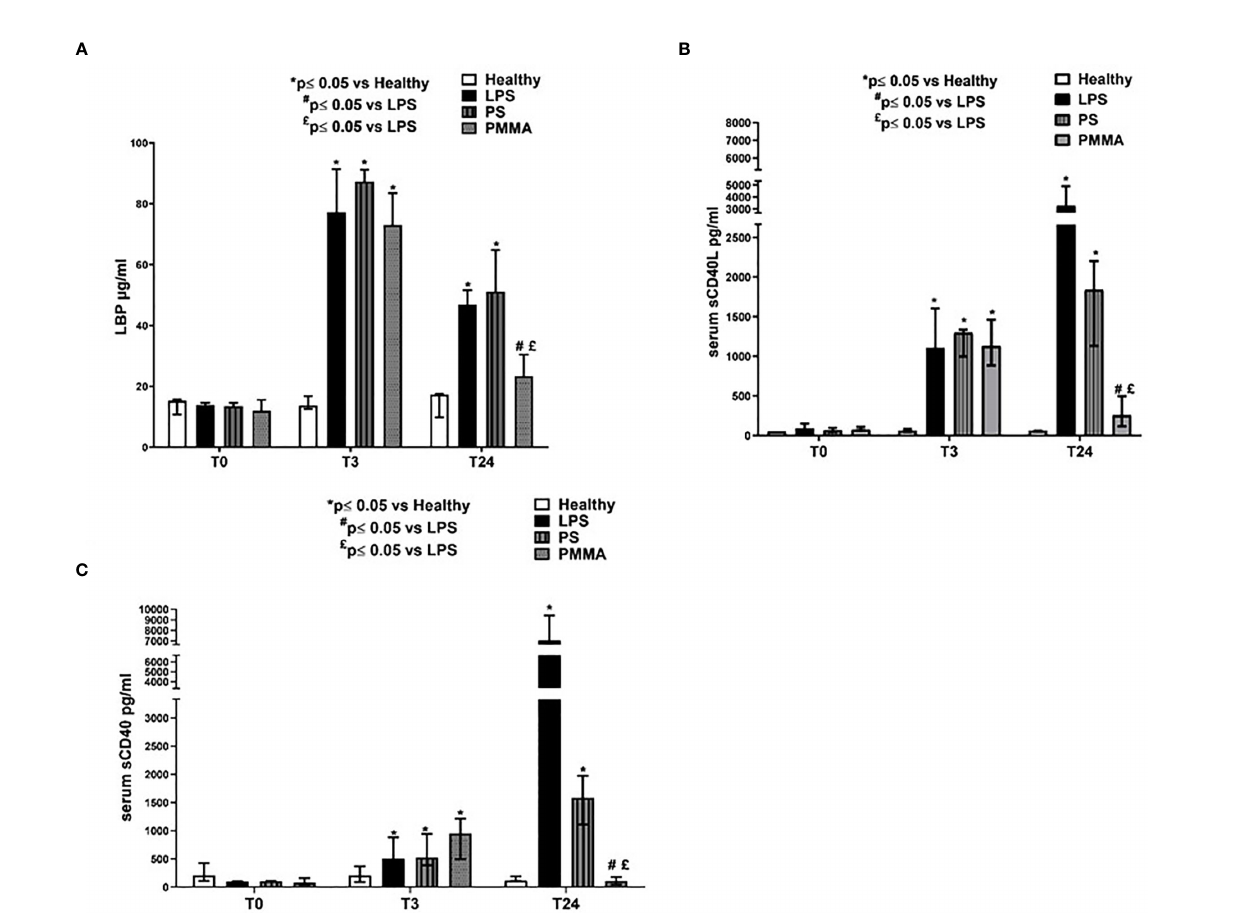
FIGURE 5 | PMMA-CVVH treatment modulated TLR-4 signaling and reduced sCD40L and sCD40 sera levels. (A) ELISA assay showed signi fi cantly increased level of serum LBP in endotoxemic pigs after 3 and 24 h from LPS infusion respect to healthy group. A strong reduction in serum LBP levels was found after PMMA- CVVH treatment ( # p < 0.05 vs LPS, and £ p < 0.05 vs PS). PS-CVVH did not modulate LBP sera levels. (B, C) ELISA assay showed signi fi cantly increased level of serum sCD40L (B) and sCD40 (C) in endotoxemic pigs after 3 and 24 h from LPS infusion respect to healthy group. A signi fi cant strong decrease in serum sCD40L and sCD40 levels was found after PMMA-CVVH treatment ( # p < 0.05 vs LPS, and £ p < 0.05 vs PS). PS-CVVH reduced sCD40L and sCD40 sera levels but it did not reach the basal condition as with PMMA treatment. (A – C) The histograms represent the median ± IQR of at least fi ve animals for each group (Healthy group and PMMA group, n = 7 for all time points; LPS group, T0-T3 n = 7, T10 -T24 n = 5; PS group, T0-T3-T10 n = 7 and T24 n = 6). Statistically signi fi cant differences were assessed by the Mann – Whitney test (*p < 0.05 vs Healthy, # p < 0.05 vs LPS, and £ p < 0.05 vs